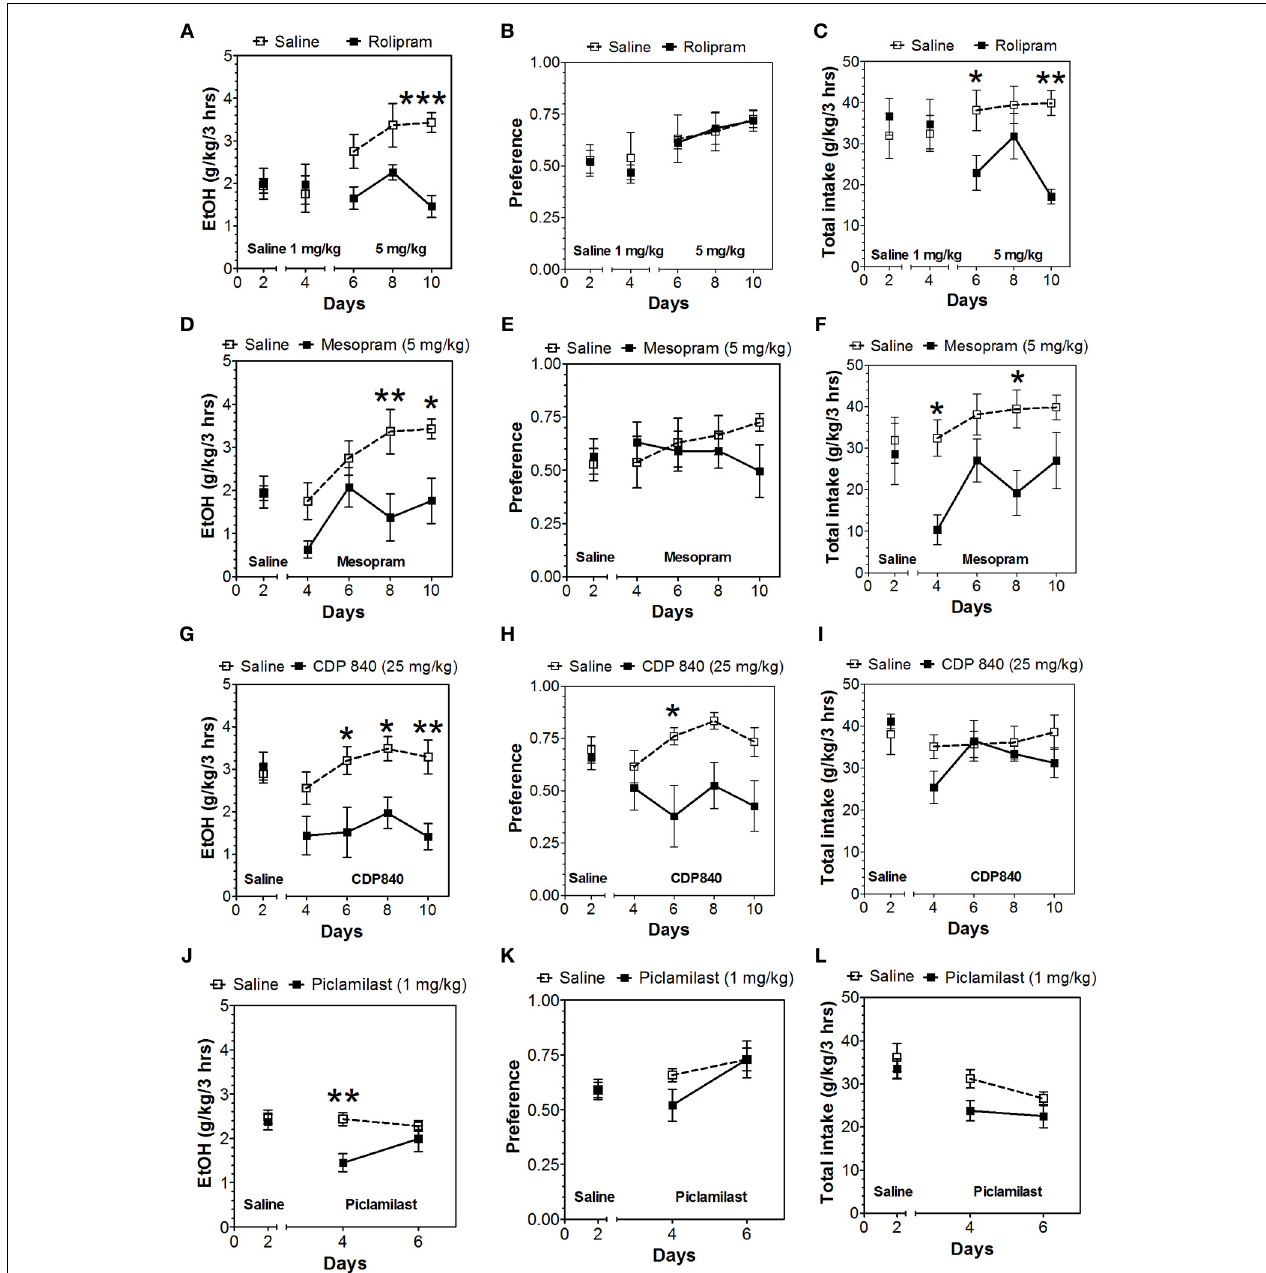
FIGURE 6 | Effects of PDE4 inhibitors on alcohol intake during a limited access (3-h) two-bottle choice Drinking in the Dark test. Ethanol consumption is presented as g/kg/3h: (A) Rolipram (D) Mesopram (G) CDP840 (J) Piclamilast. Preference for ethanol: (B) Rolipram (E) Mesopram (H) CDP840 (K) Piclamilast. Total fluid